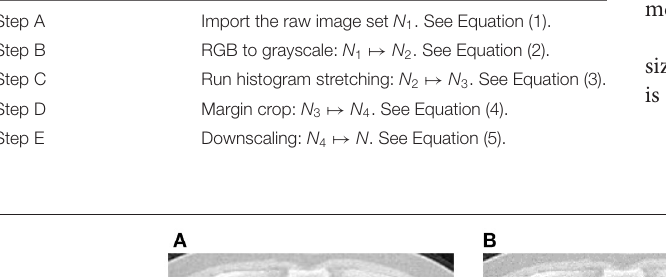
Algorithm 1 | Pseudocode of five-step preprocessing.